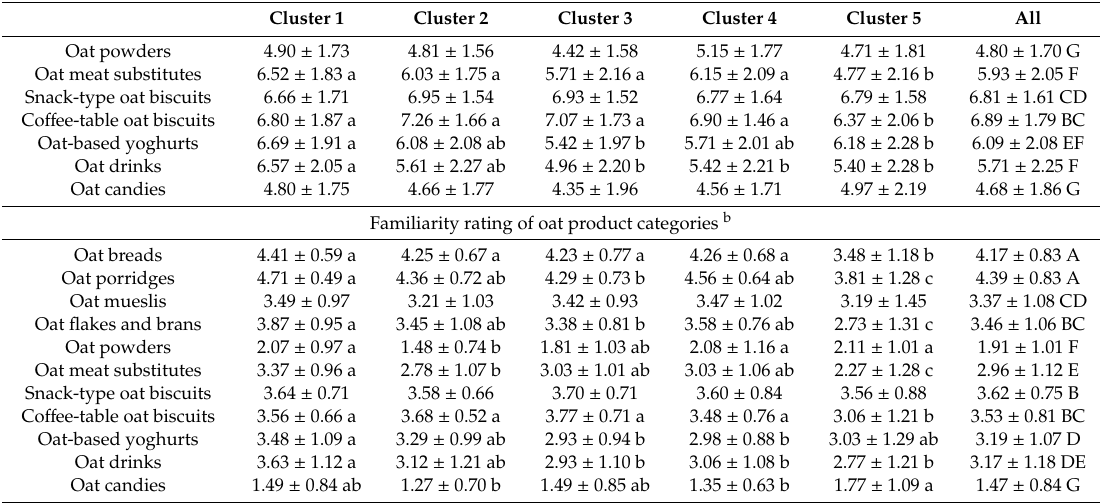
a Clusters based on four class variables: gender and country of origin (Table 1), Food Neophobia Scale (FNS, [31]) status and General Health Interest (GHI, [32]) status. FNS and GHI scores of all 381 participants were first used to create two subsets (less FN / HI or more FN / HI). Mean FNS or GHI scores for the two subsets among all participants are shown brackets after percentages. b Mean ratings ( ± standard deviations; scale 1–7; 1 =